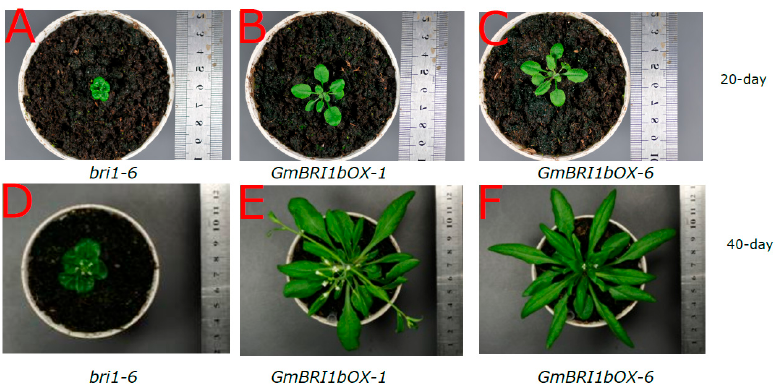
Figure 5. Ectopic over-expression of GmBRI1b restored the wild-type leaf phenotype in the transgenic bri1-6 mutant. Leaf phenotypes of the 20-day-old bri1-6 mutant ( A ); and the two corresponding GmBRI1b over-expression lines GmBRI1bOX-1 ( B ) and GmBRI1bOX-6 ( C ); Leaf phenotypes of the 40-day-old bri1-6 mutant ( D ); and the two corresponding GmBRI1b over-expression lines GmBRI1bOX-1 ( E ) and GmBRI1bOX-6 ( F ).